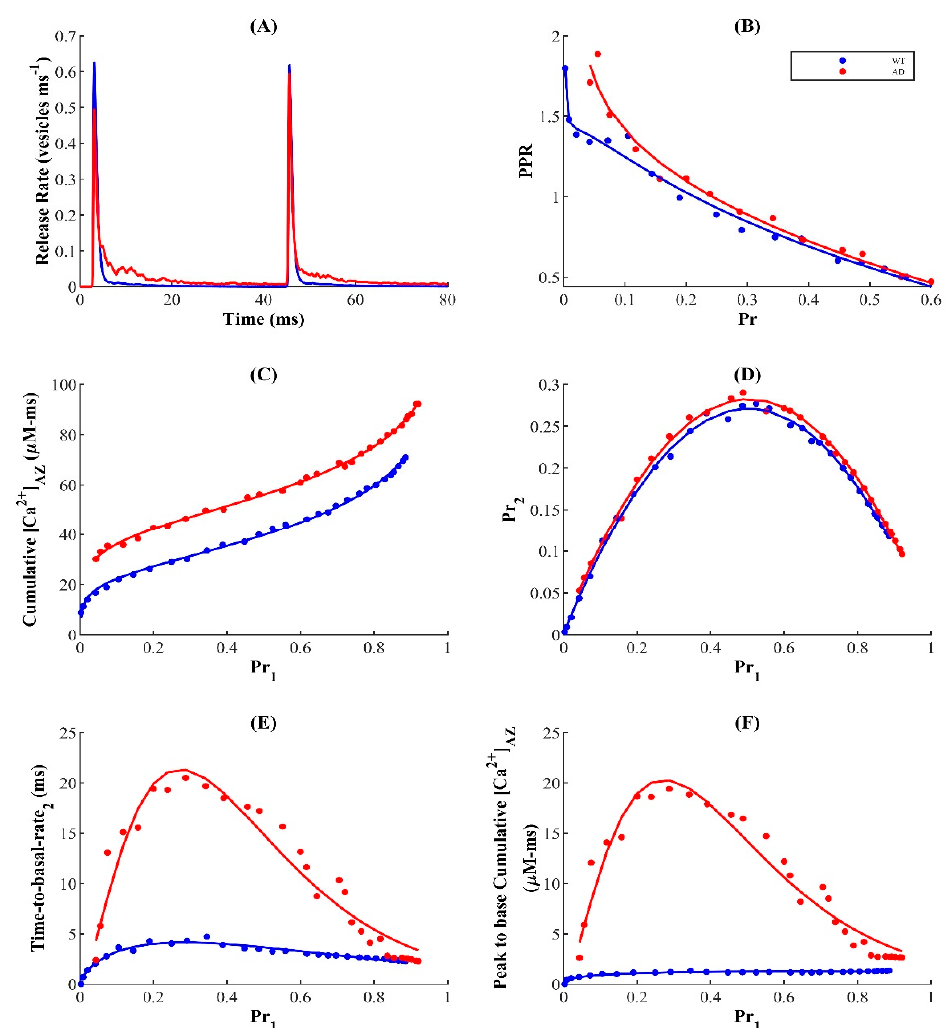
Figure 6. FAD − associated Ca 2+ upregulation enhances STF: ( A ) Release profile following paired − pulse stimulation protocol; ( B ) PPR is inversely related to intrinsic P r (obtained after first pulse), and is higher in the AD − affected synapse; ( C ) Similar to the first pulse (Figure 3G), cumulative Ca 2 + after the second pulse increases with the P r and is higher in the AD − affected synapse; ( D ) Pr in response to the second pulse (P r2 as a function of P r following the first pulse (P r1 Higher values indicate that the synapse responds more strongly to the subsequent stimulus in a paired − pulse protocol; ( E ) Decay time of release rate after second pulse also exhibits a biphasic behavior; ( F ) Cumulative [𝐶𝑎 (cid:3002)(cid:3027)(cid:2870)(cid:2878) ] following the second pulse reflects the biphasic behavior observed in time delay of peak − to − basal release rate in panel ( E ).